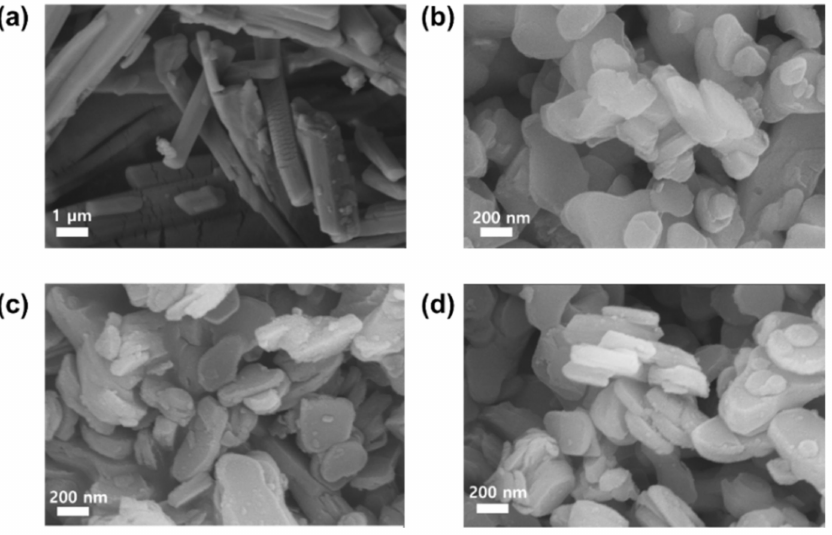
Figure 4. FE-SEM images of ( a ) intact NIC, ( b ) HT, ( c ) DHT, and ( d ) NIC–DHT